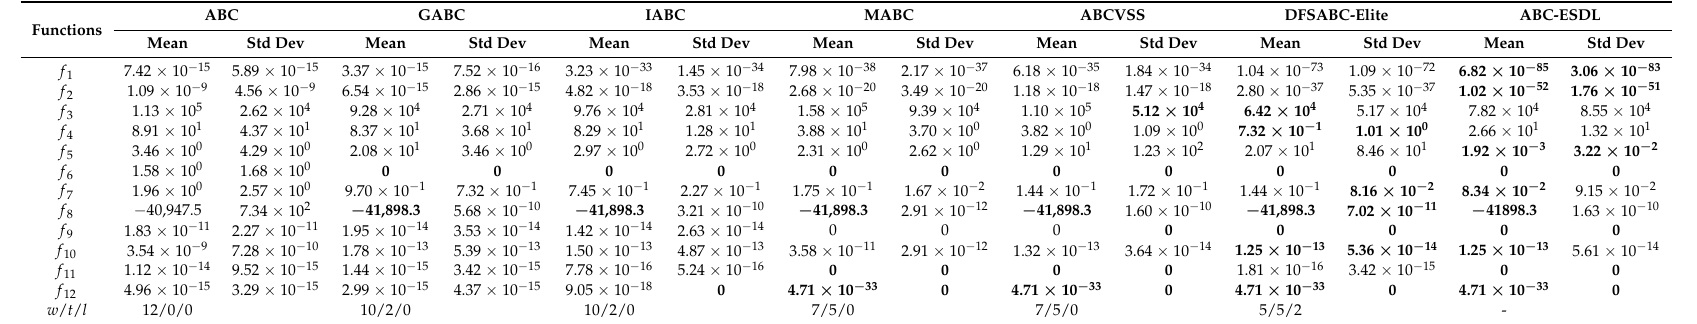
Table 3. Results of ABC-ESDL and six other ABC algorithms for D =